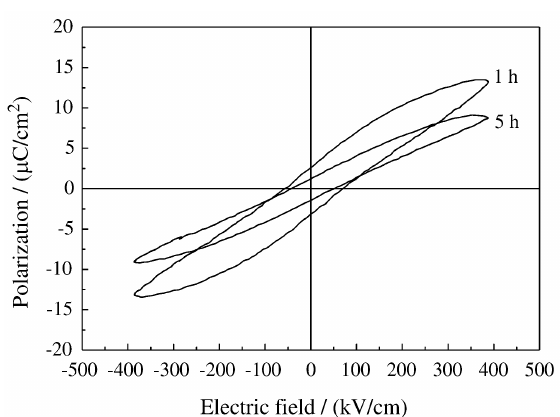
Figure 4. Hysteresis loop, measured at 100 Hz, of SBN film crystallized at 700 °C for 1 h and 5